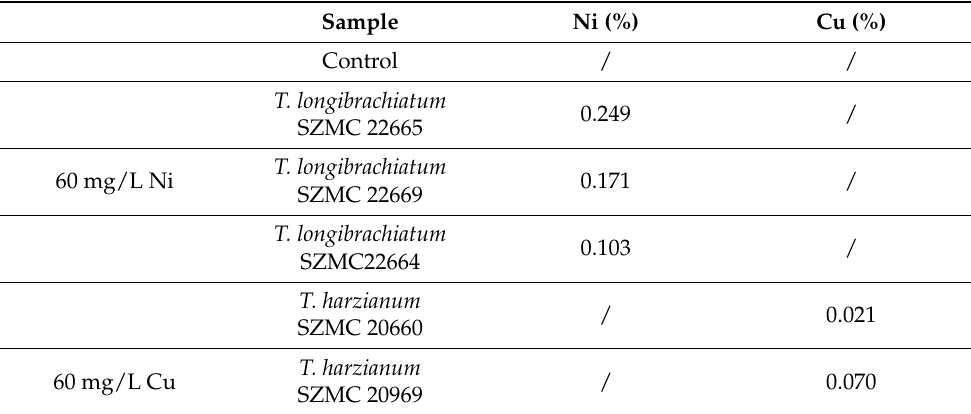
Table 5. XRF analysis for Trichoderma fungal cells grown on clear PDA (control) and the PDA containing 60 mg/L Ni or Cu